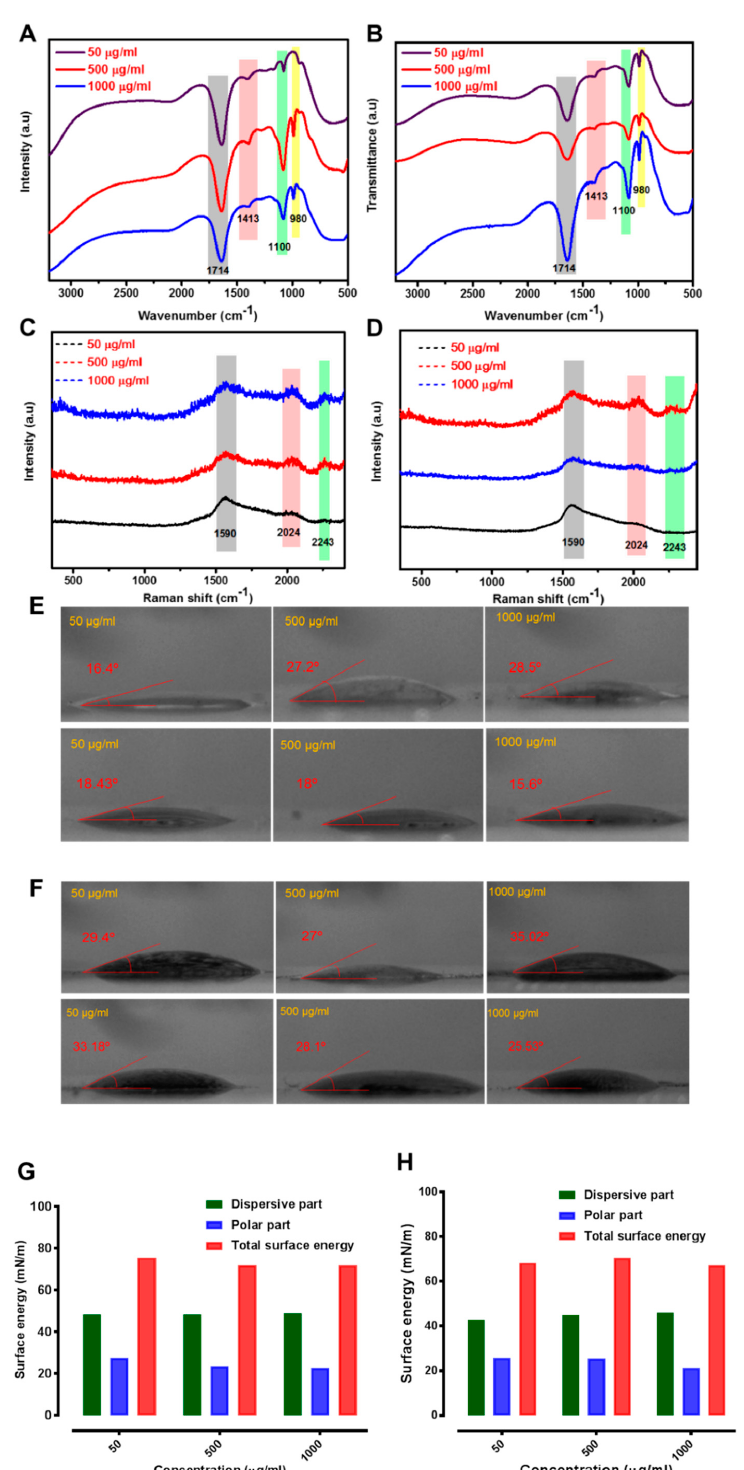
Figure 6. ( A , B ) FTIR spectra of CathD/CathL-linked graphene oxide (GO) at 50, 500 and 1000 µ g/mL concentrations of GO. ( C , D ) Raman spectra of CathD/CathL-linked GO at 50, 500 and 1000 µ g/mL GO concentrations. ( E , F ) Contact angle profiles of CathD/CathL-linked GO interfaces at 50, 500 and 1000 µ g/mL concentrations of GO. The diiodomethane contact angle was determined to calculate the surface energy of the enzymes, GO and the interfaces of GO with enzymes. ( G , H ) The surface energy profile of GO-CathD/CathL interfaces which have three segments of total surface energy, dispersive surface energy and polar surface energy—the profiles correspond to 50, 500 and 1000 µ g/mL concentrations of GO which had been treated with CathD and